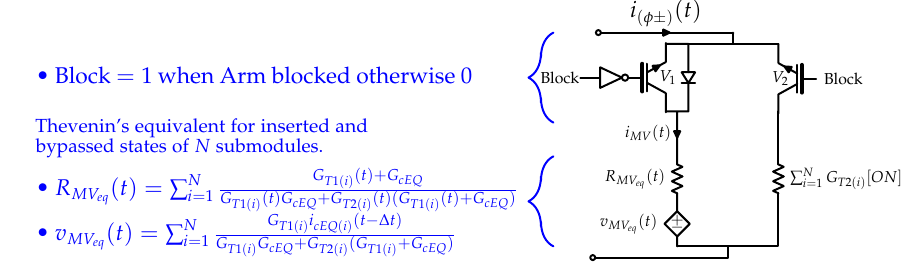
Figure 5. Arm Thevenin equivalent.